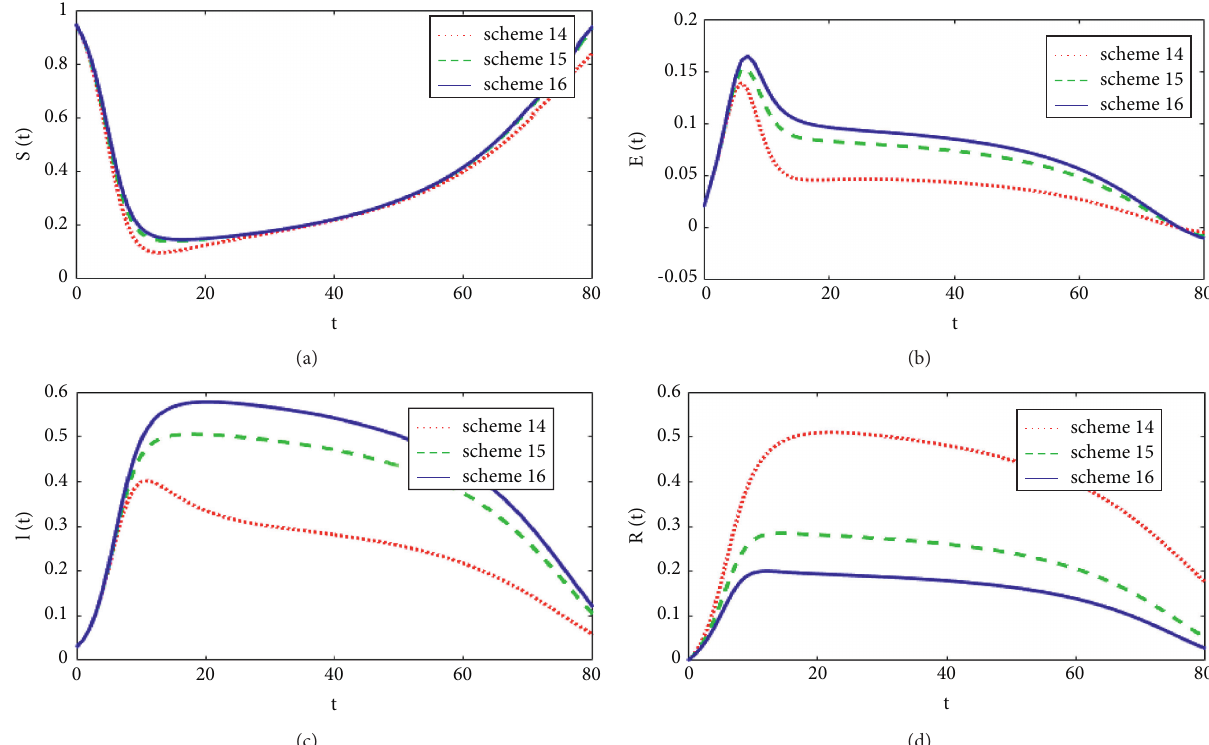
Figure 7: Changes in the population density curve of the four categories of netizens at different values of β .